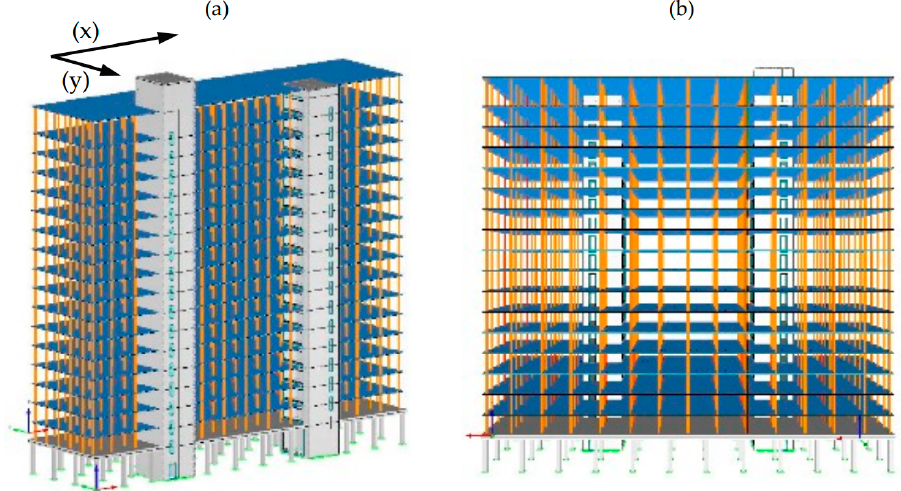
Figure 5. Numerical Model of the UBC TWB: ( a ) isometric view and ( b ) front view.